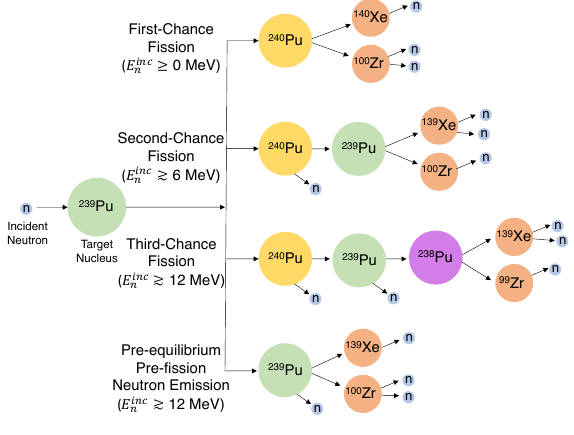
Figure 1. An illustration of the paths to various fissioning nuclei for incident neutron energies below 20 MeV is shown here for a 239 Pu target nucleus. This is a reproduction of Fig. 1 of Ref. [11]. The evolution of the PFNS with increasing incident neutron en- ergy is the convolution of these various possible fission paths, each of which may produce di ff erent features in the measured neutron spectrum in coincidence with